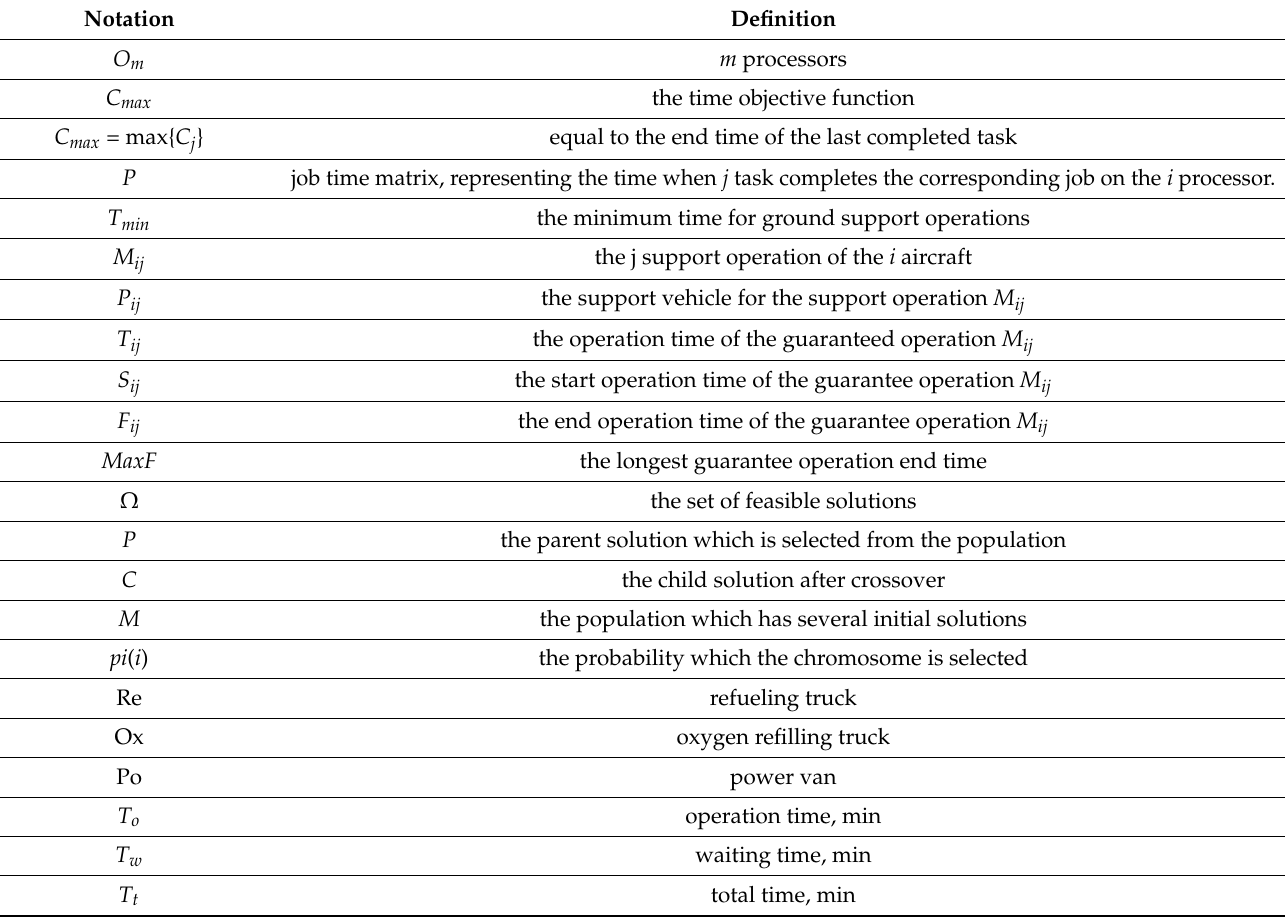
Table 2. Notation and